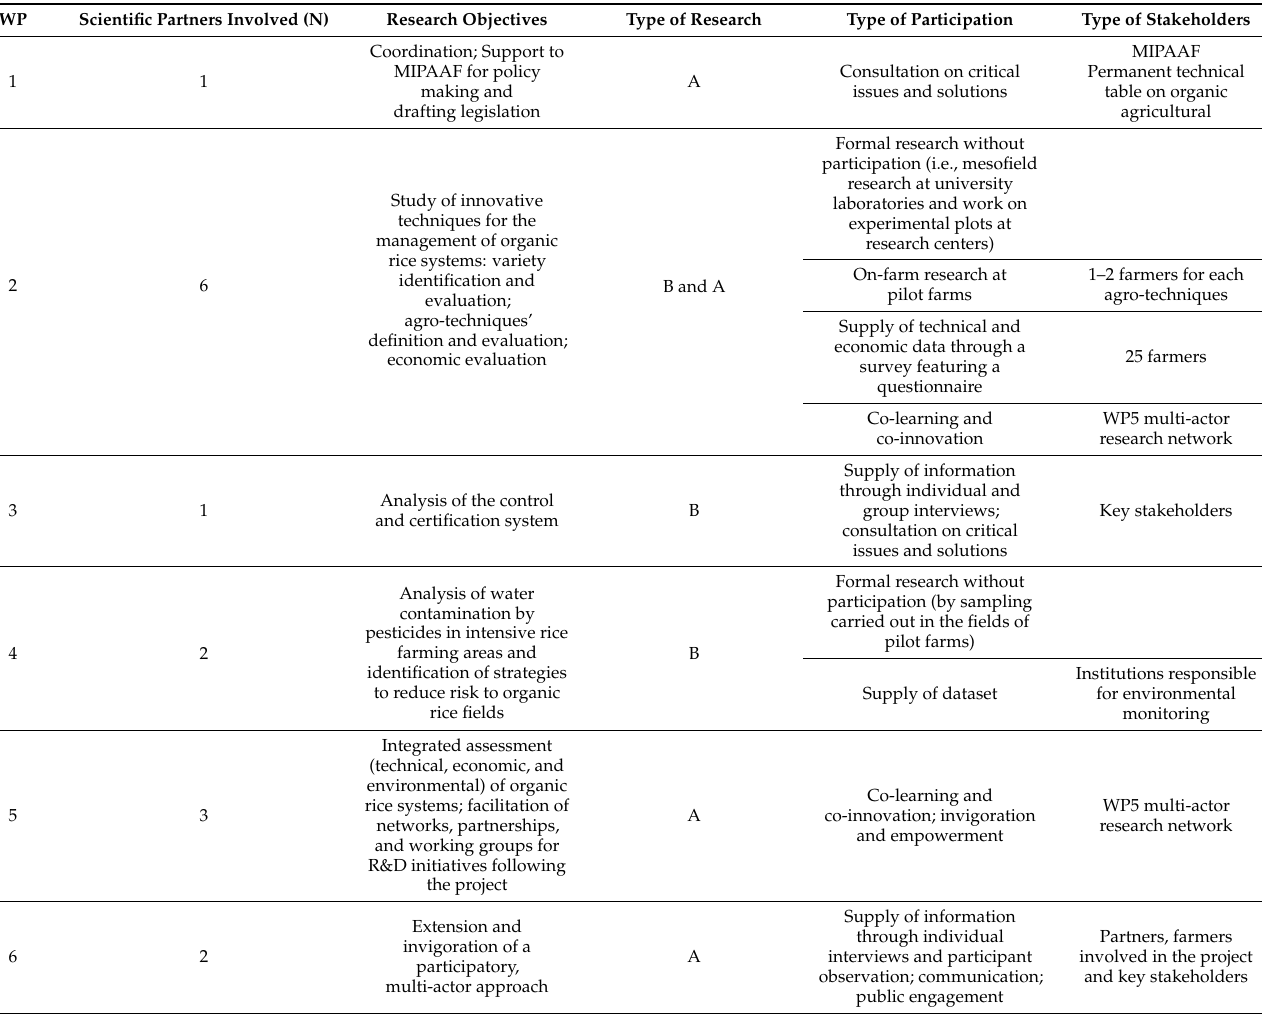
Table 3. RBS research plan.